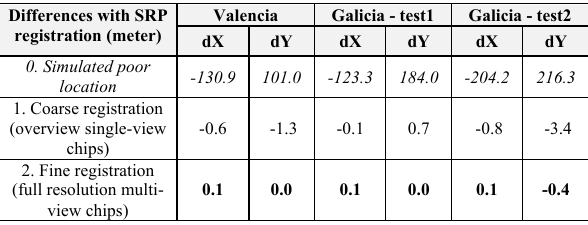
Table 5. Performance of SRP for images with poor native